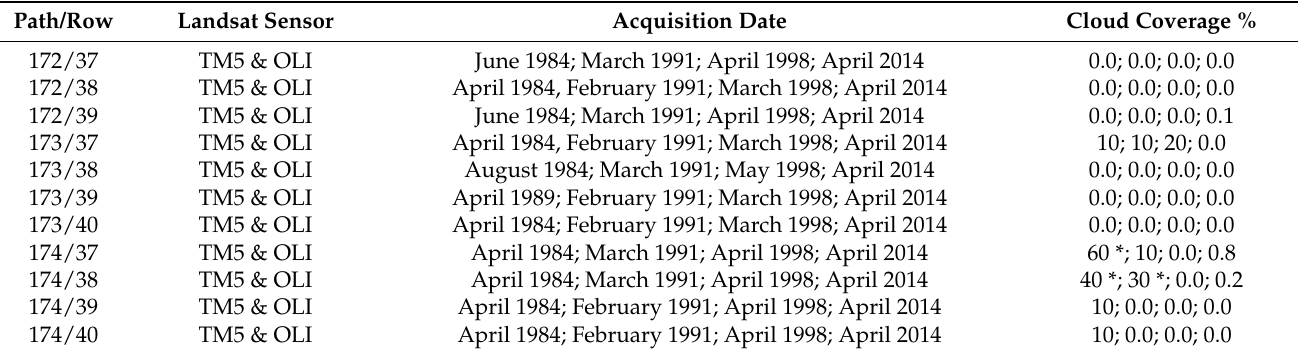
Table 1. Landsat tiles used to develop the Jordan National Land Cover Database. [Source